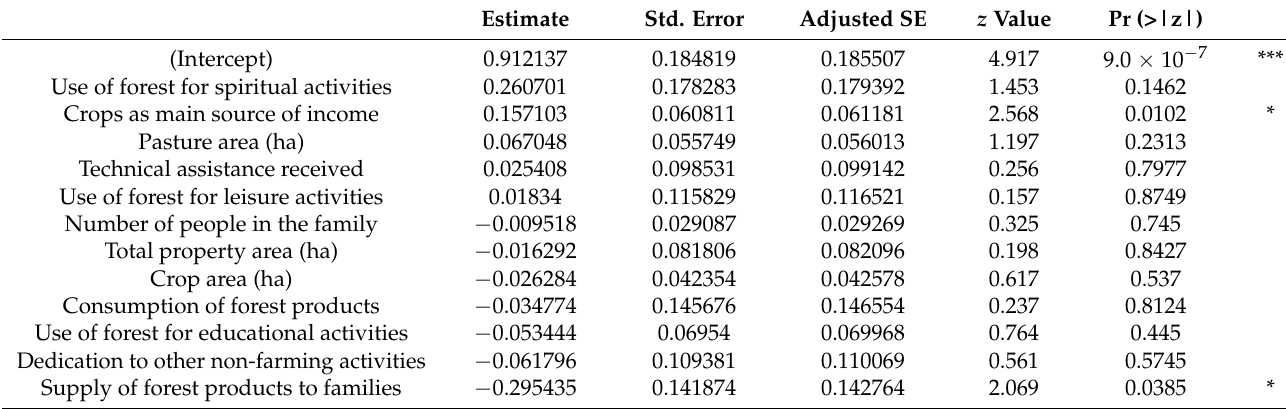
Table A2. Influence of the socioeconomic variables of the rural properties on the size of the Polylepis forest areas that the families intend to restore.